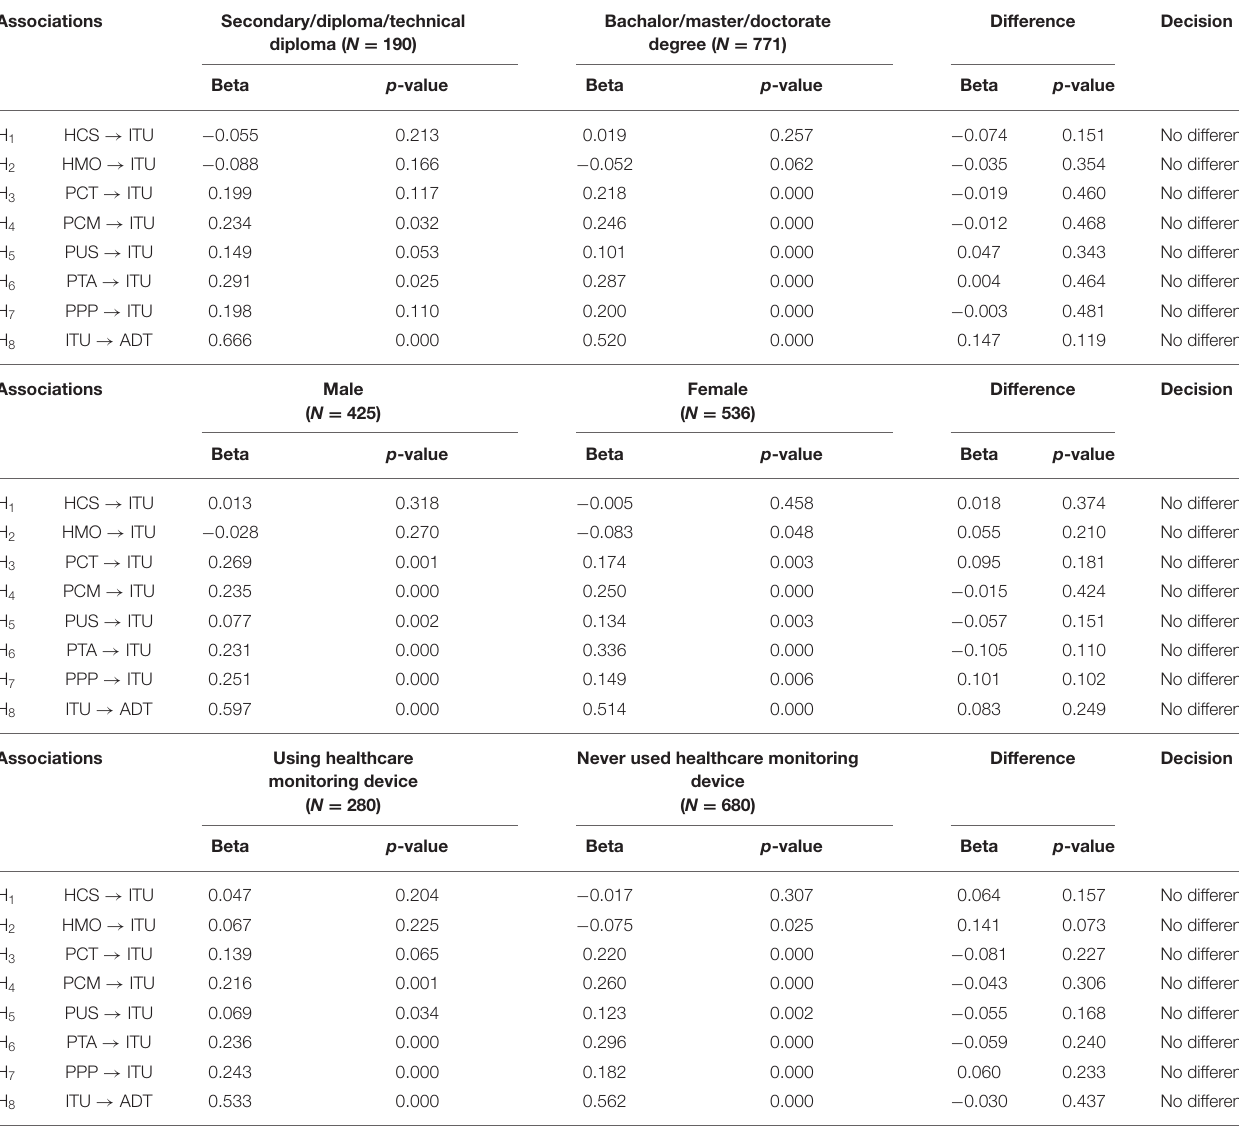
TABLE 6 | Multi-group